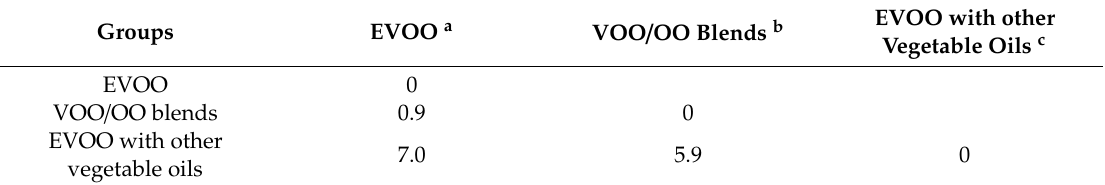
Table 4. Interclass distances between three classes of olive oils based on the SIMCA class projections for the Raman spectra collected in the 250–1850 cm − 1